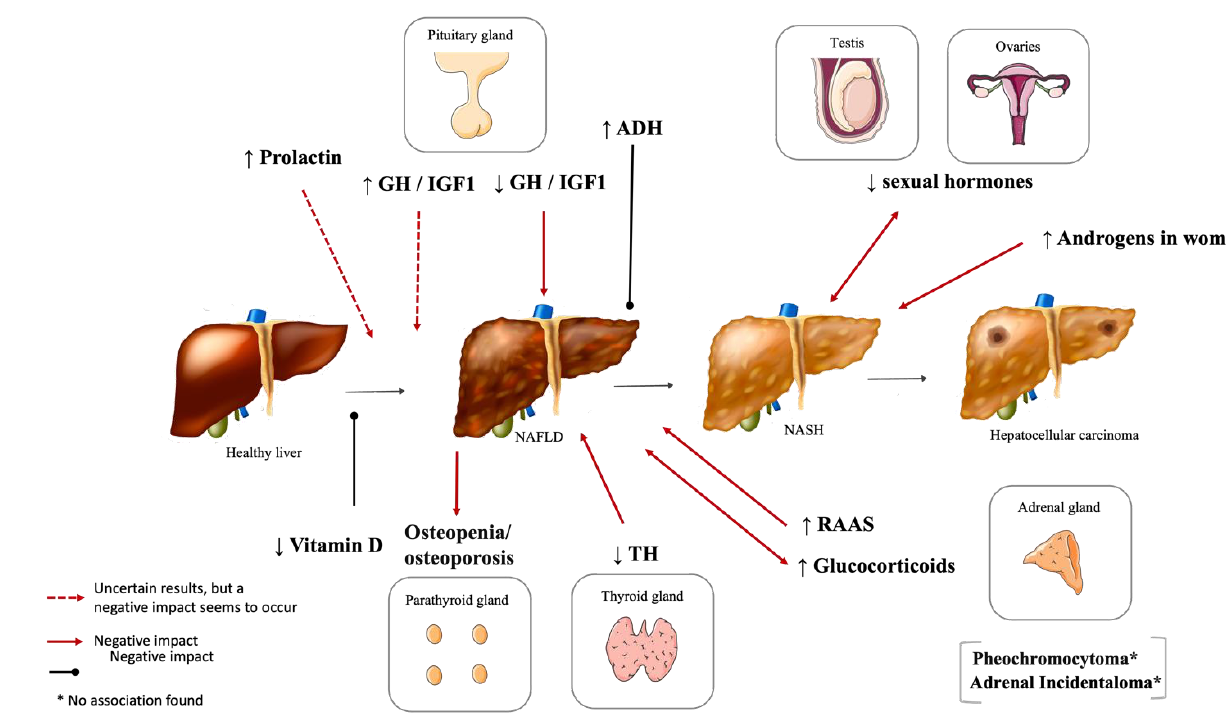
Figure 6. Summary figure of the crosstalk between the endocrine axes and NAFLD. NAFLD: Non- alcoholic fatty liver disease; NASH: Nonalcoholic steatohepatitis; GH: Growth hormone; IGF1: Insulin-like growth factor 1; ADH: antidiuretic hormone; PCOS: Polycystic ovary syndrome; TH: Thyroid hormones; RAAS: Renin – Angiotensin – Aldosterone System. [Viktoriia Kasyanyuk] © 123RF.com (accessed on 22 February 2022) and Servier Medical Art by Servier. Table 1. Effect of endocrine hormones on the different factors involved in nonalcoholic fat liver disease development.